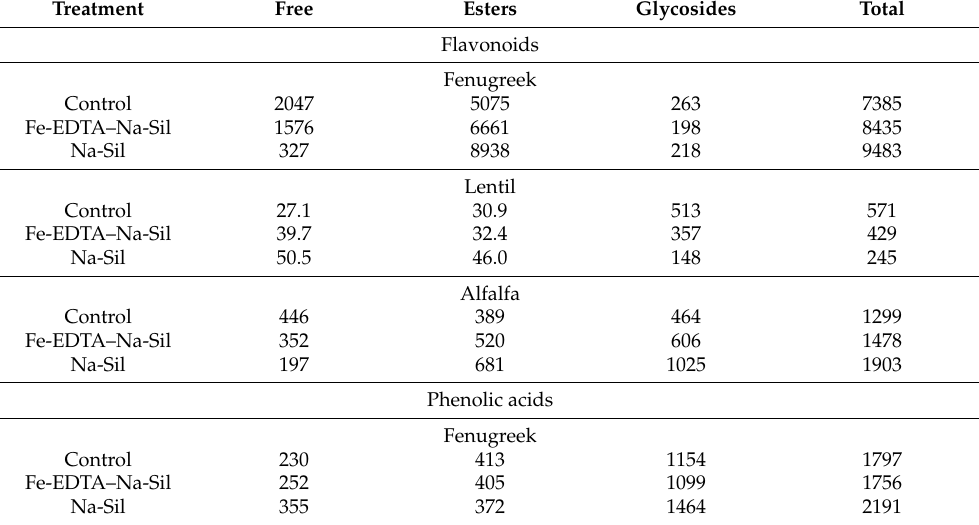
Table 6. The contents of total flavonoids and phenolic acids (free and released from ester and O -glycoside forms) in legume sprouts ( µ g/g DW) treated with elicitors during growth.